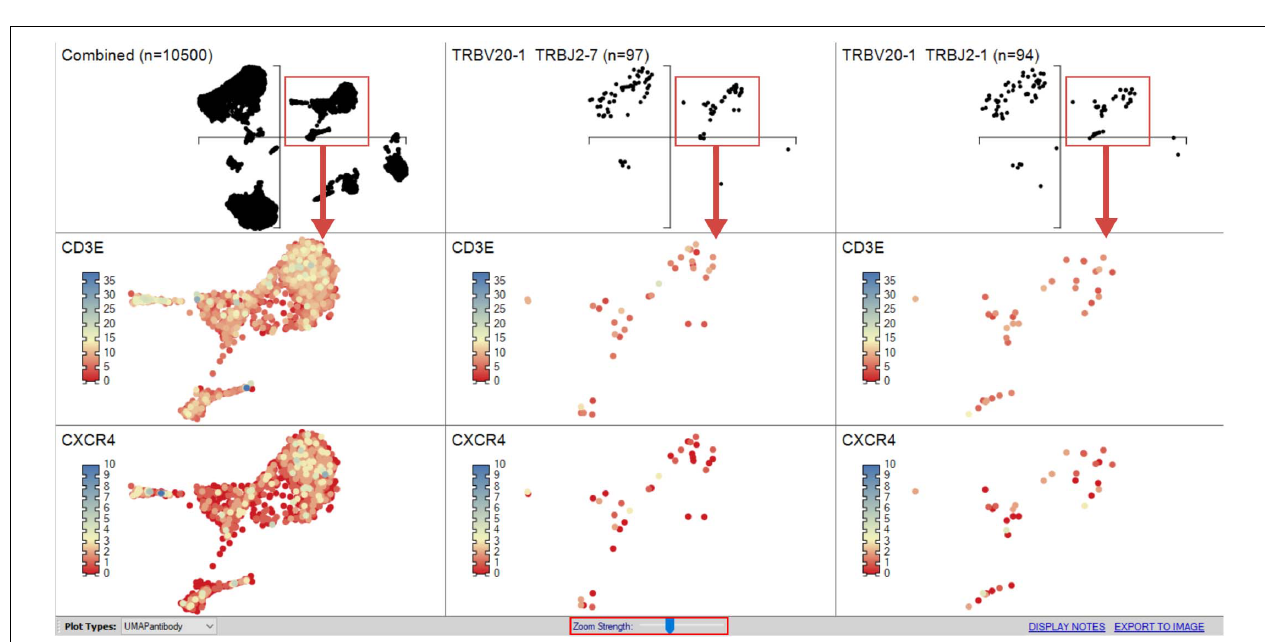
FIGURE 9 | Heatmapping scRNA-seq gene expression on UMAP. Combined sample or subpopulation UMAPs can be compared on a single screen simultaneously providing an overview and more discrete dissection of sample. The “Zoom Strength” slider (highlighted red) enables focus on a particular region of interest directed by grouped analyses for heatmapping gene expression between samples as dictated by interest of prior differential gene expression analyses.